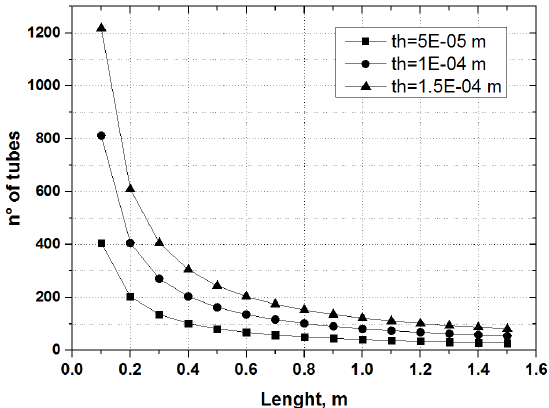
Figure 7. Number of tubes vs. length for different thickness values at 623 K, 1 MPa pressure, and a tube diameter of 10